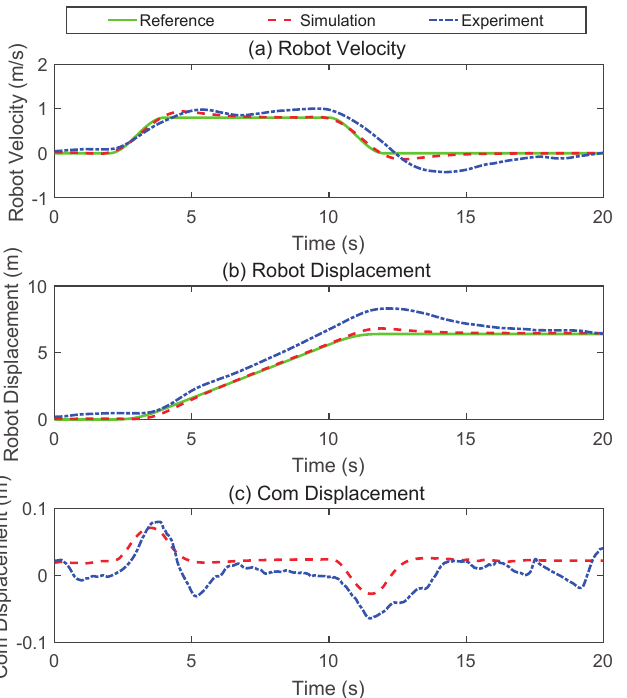
Figure 10. The simulation results of velocity tracking. ( a ) The velocity profile of the robot. ( b ) The displacement profile of the robot. ( c ) The horizontal displacement of the